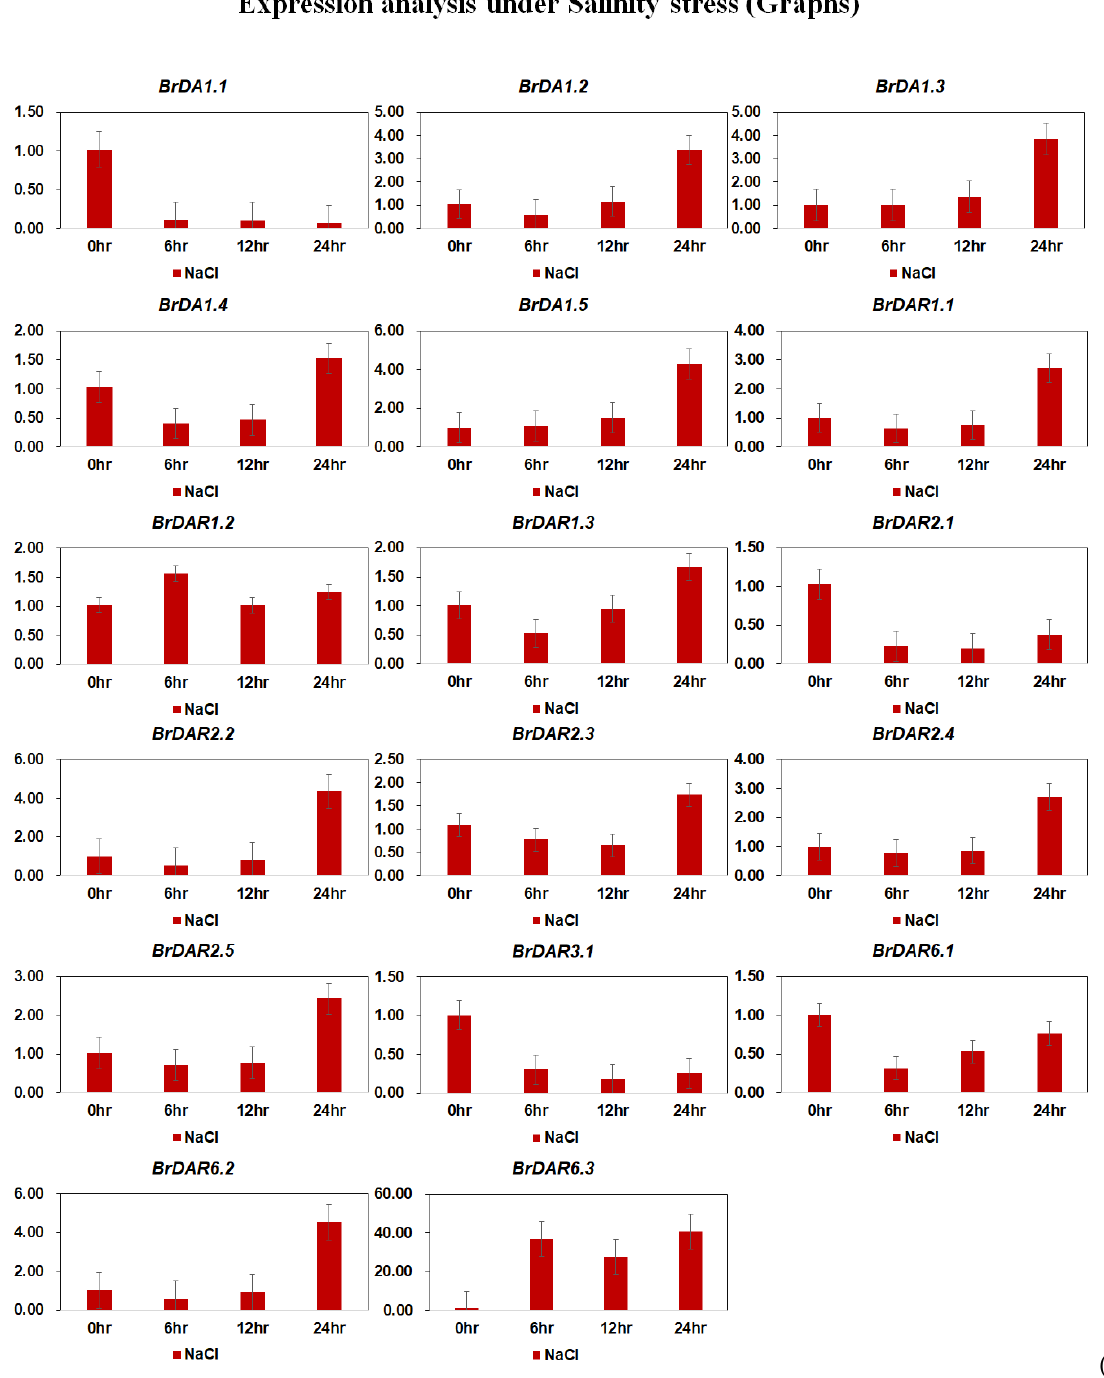
Figure 10. (a) Expression profiling of BrDA1 & DAR genes under drought stress. Sampling was per- formed at 0 h (CK), 2 h, 4 h, 6 h, and 8 h. 2 −∆∆ CT method was used to examine the results. (b) Expres- sion patterns of BrDA1 & DAR genes under salinity stress. Sampling was performed at 0 h (CK), 6 h, 12 h, and 24 h. 2 −∆∆ CT method was used to analyze the